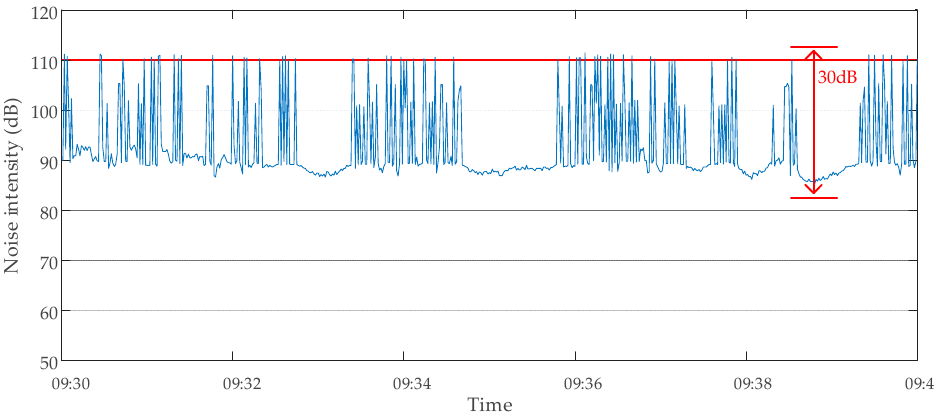
Figure 14. Monitoring data of neutral DC of transformer D on 05 November 2019. Table 4. Transformer D data validity analysis results. Date of Analysis